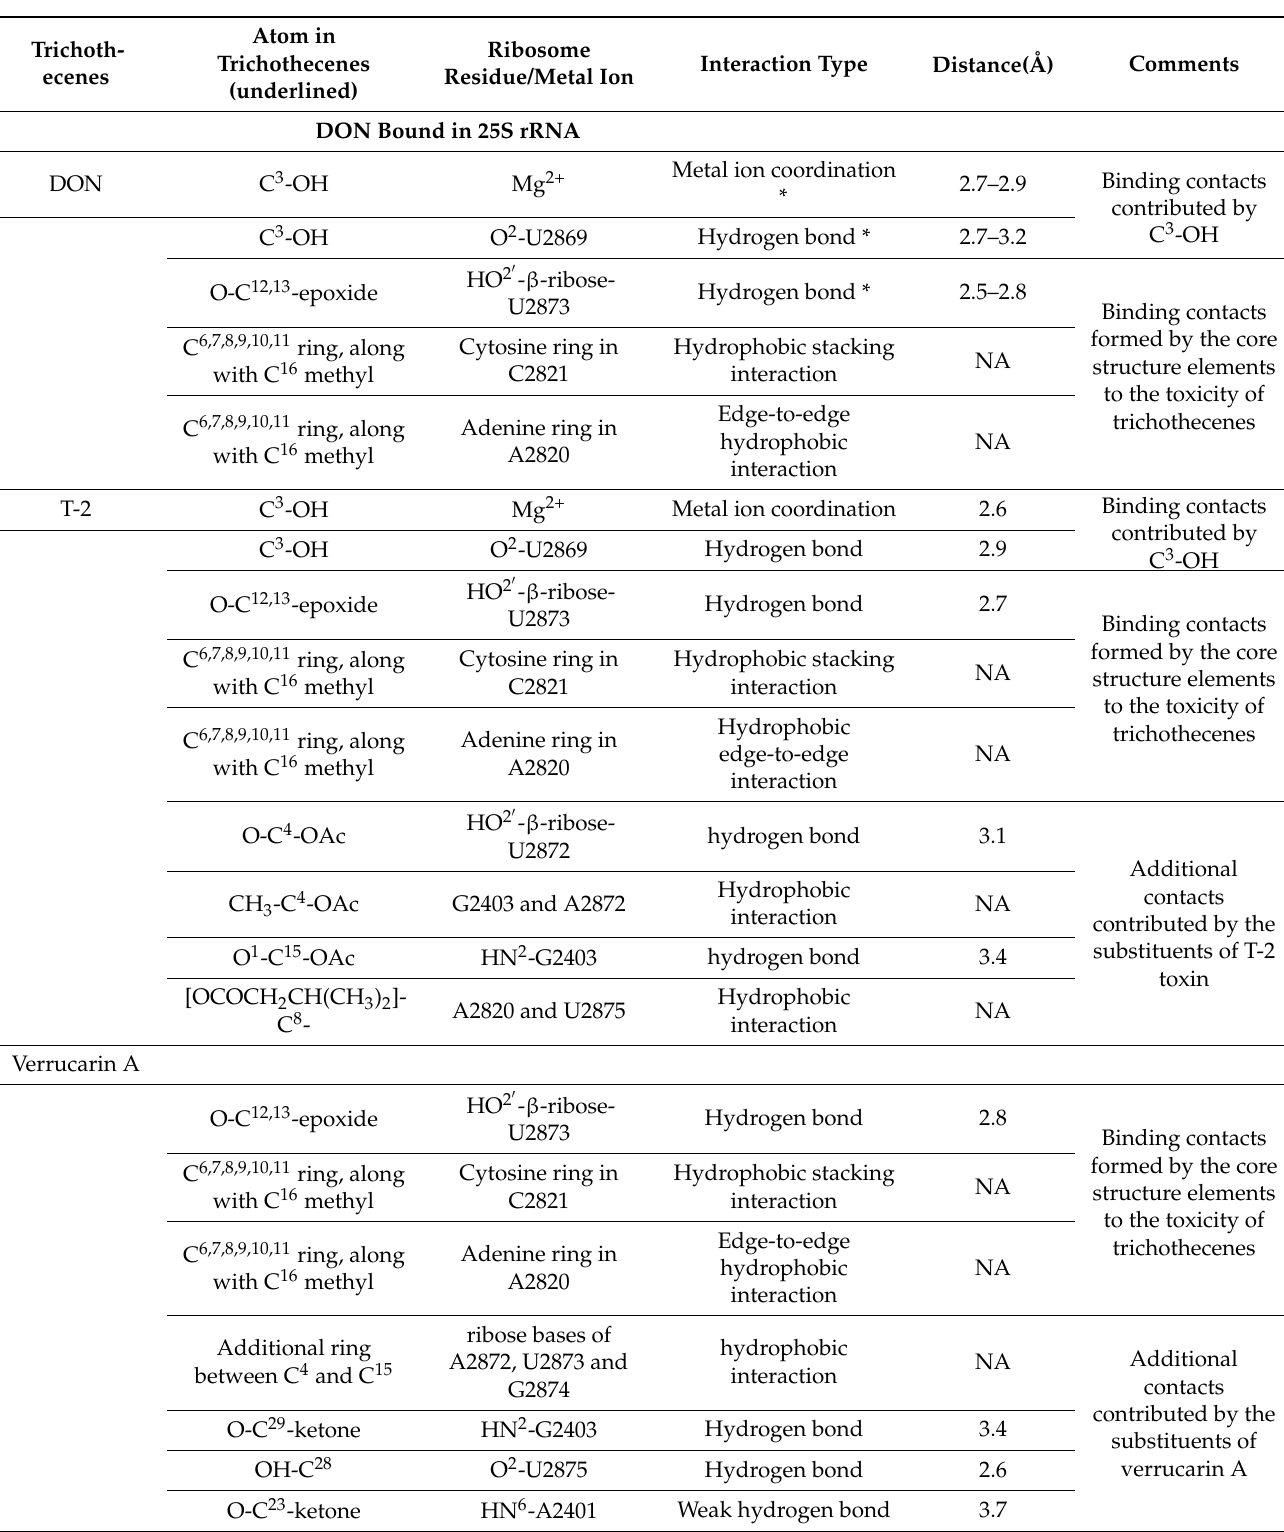
Table 1. Interactions between trichothecenes mycotoxins (DON, T-2 toxin and verrucarin A) and 80 S ribosome of yeast. Trichoth- ecenes